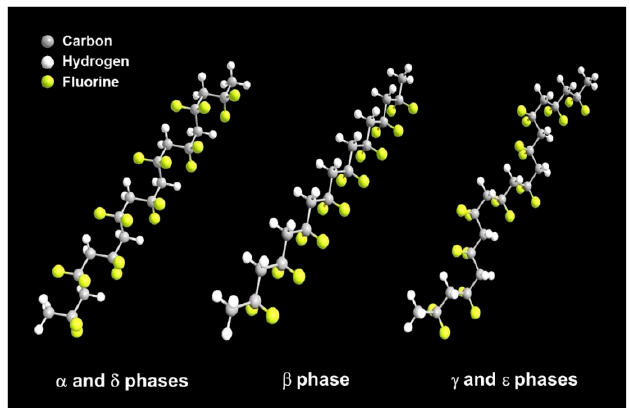
Figure 9. Conformations of five phases of PVDF molecular (reprinted from [51]).